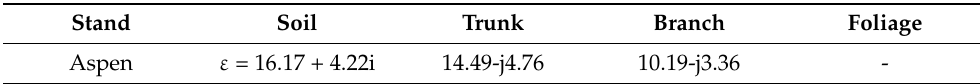
Table 2. Input parameters of